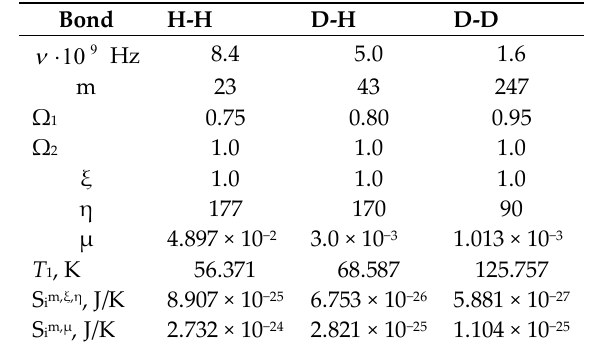
Table 1. Information entropy for partial and complete deuteration of the hydrogen bond in the benzoic acid